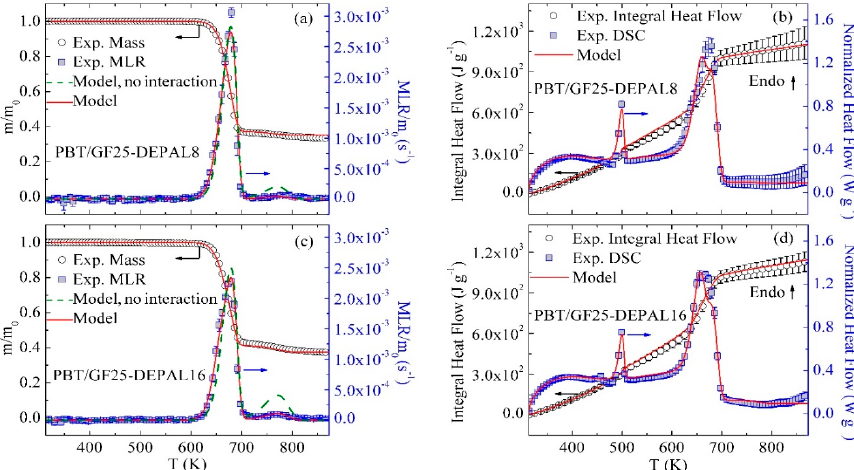
Figure 3. Experimental and simulated TGA and DSC data obtained for ( a , b ) PBT/GF25-DEPAL8